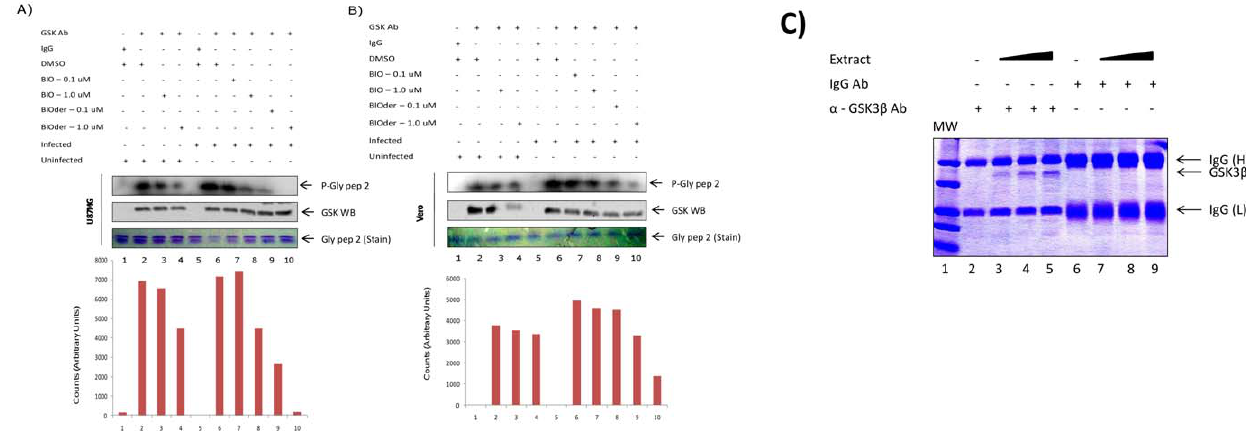
Figure 4. BIO and BIOder inhibit GSK-3 b in VEEV infected cells. A ) U87MG astrocytes and B ) Vero cells were pretreated for 2 hours with DMSO, BIO (0.1 and 1.0 uM), or BIOder (0.1 and 1.0 uM), infected with VEEV TC-83 at MOI 0.1, and post-treated with DMSO, BIO, or BIOder. Mock infected cells were treated with DMSO, 1 uM BIO, or 1 uM BIOder. Twenty-four hours post infection cells were collected and protein extracts prepared. One mg of extract was IPed at 4 u C overnight with GSK-3 b antibody. The next day complexes were precipitated with A/G beads for two hours at 4 u C. IPs were washed twice with TNE buffer and kinase buffer. Phosphorylation reactions were performed with IP material and 200 ng of glycogen synthase peptide 2 (Millipore) as substrate. Following incubation, samples were separated by SDS-PAGE, dried and subjected to analysis using Molecular Dynamics Phosphor Imager software. C ) Immunoprecipitation of GSK-3 b and IgG control from titration of extracts followed by staining. Constant amount of anti-GSK-3 b or IgG Rabbit antibodies (10 m g each) were used for overnight precipitation using 10,100, and 1000 m g of VEEV infected U87MG extracts. Samples were IPed overnight and next day Protein A and G were added, washed in TNE 150 and 0.1% NP-40 and then ran on a 4–20% followed by staining with coomassie blue. A dominant band of GSK-3 b along with both heavy and light chains are stained.